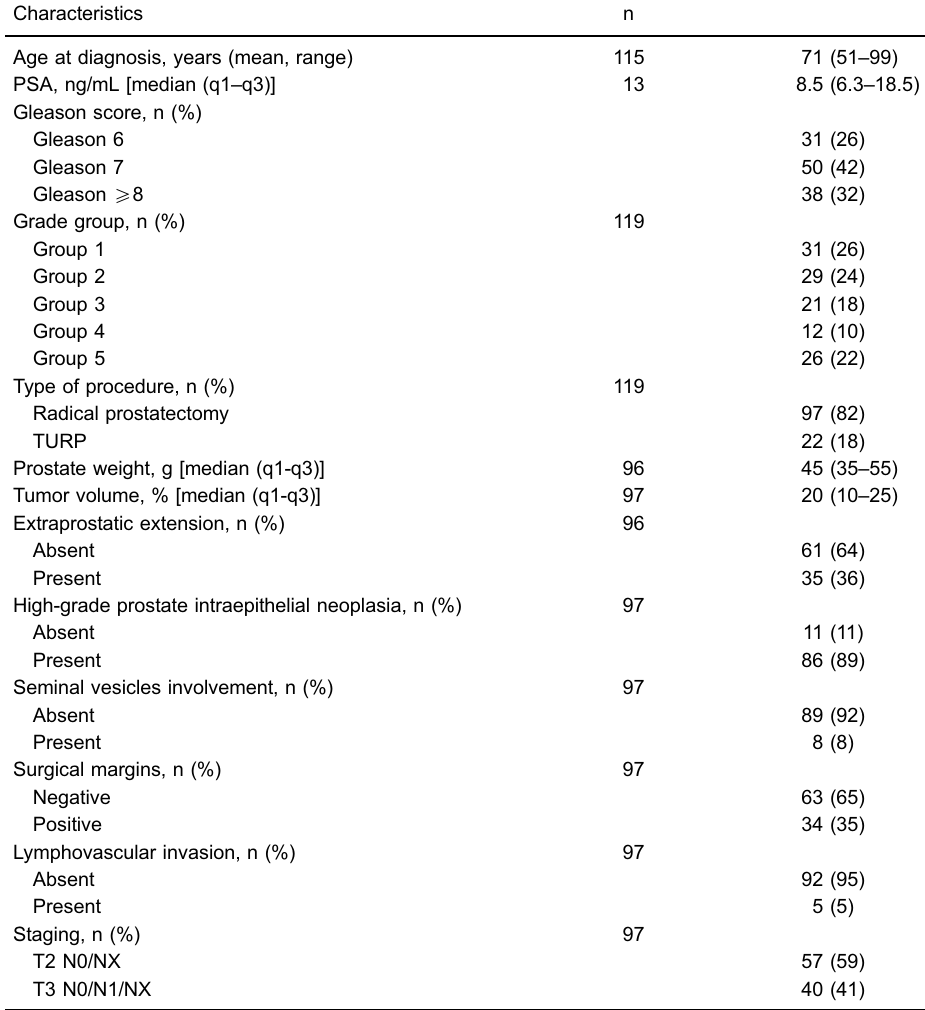
Table 1. Clinicopathological characteristics of patients treated with radical prostatectomy or transurethral resection of the prostate (TURP) for prostate cancer.